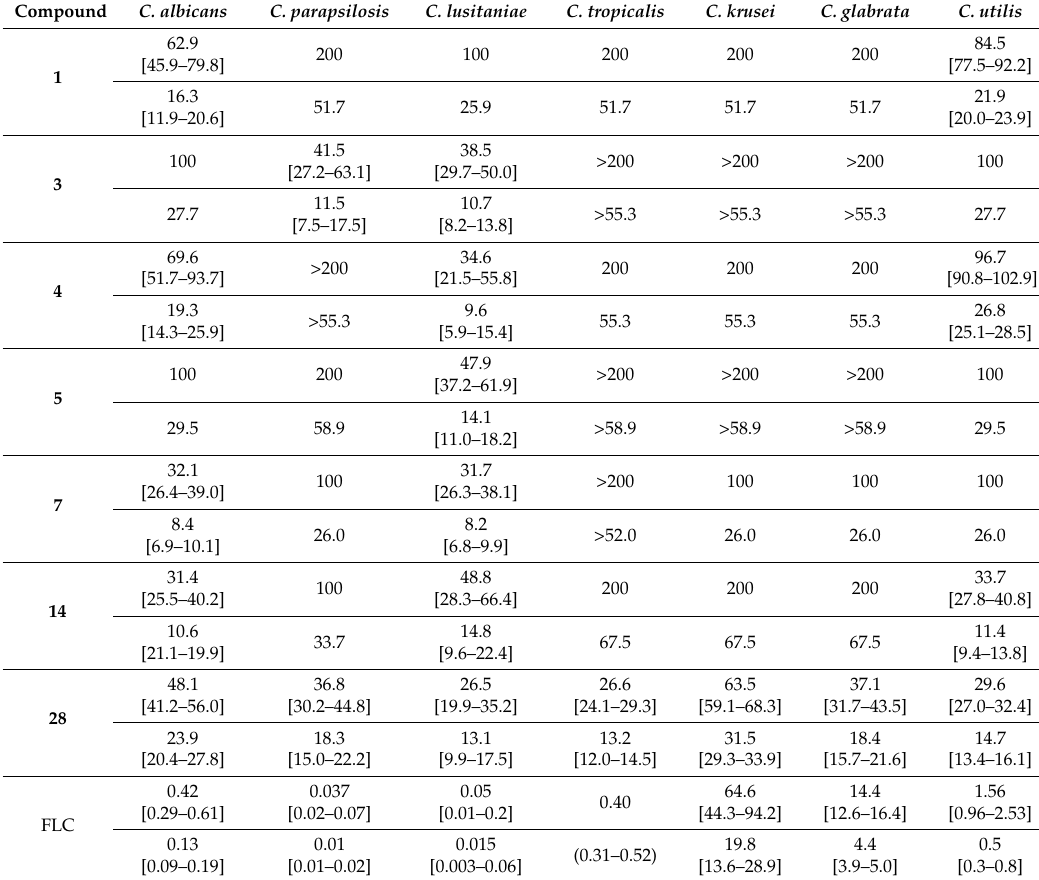
Table 3. Antifungal effect determined for compounds 1 , 3 - 5 , 7 , 14 , 28 and for the control FLC against various Candida spp. The activities are expressed as IC 50 values a,b [ µ M (above) and in µ g/mL (below)].